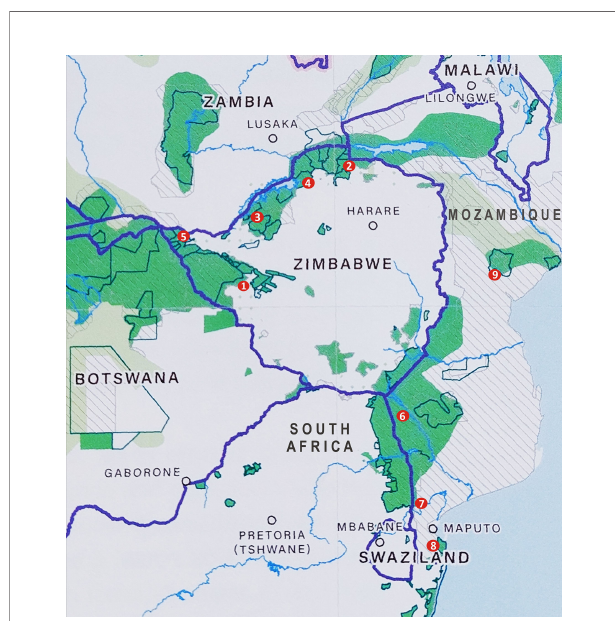
FIGURE 1 | Map of elephant range (green) in south-eastern Africa with HEC study sites marked. Zimbabwe sites: 1 Tsholotsho District; 2 Mbire District; 3 Binga District; 4 Hurungwe District; 5 Victoria Falls. Mozambique sites: 6 Limpopo National Park periphery; 7 Moamba District; 8 Maputo Special Reserve; 9 Gorongosa National Park periphery.